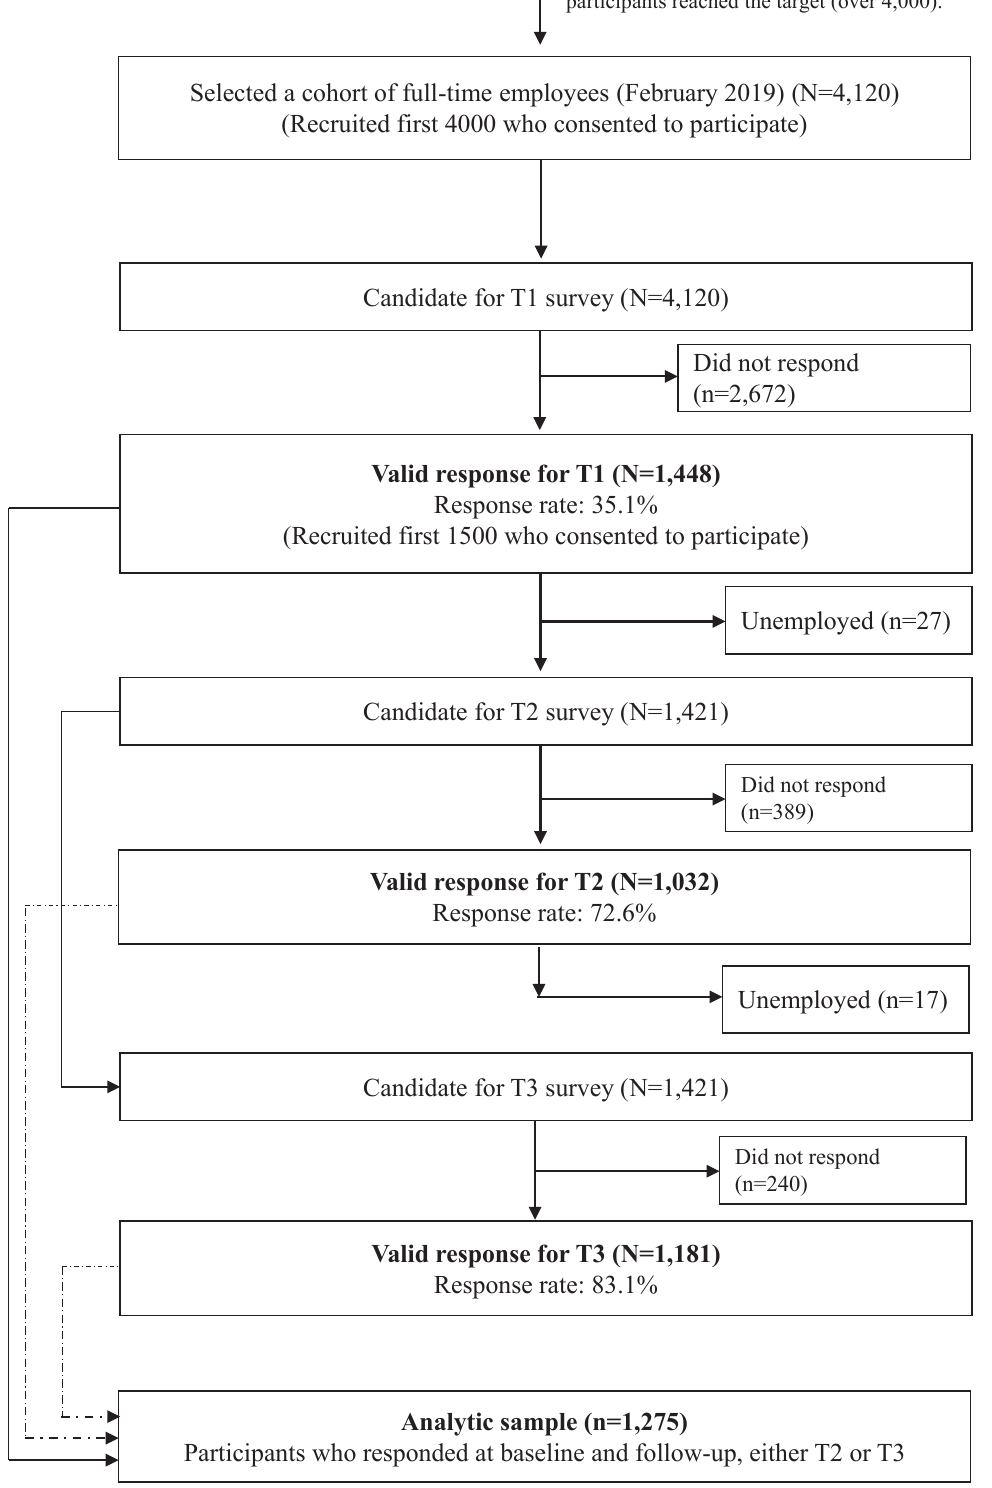
Figure 1. Flowchart of participant